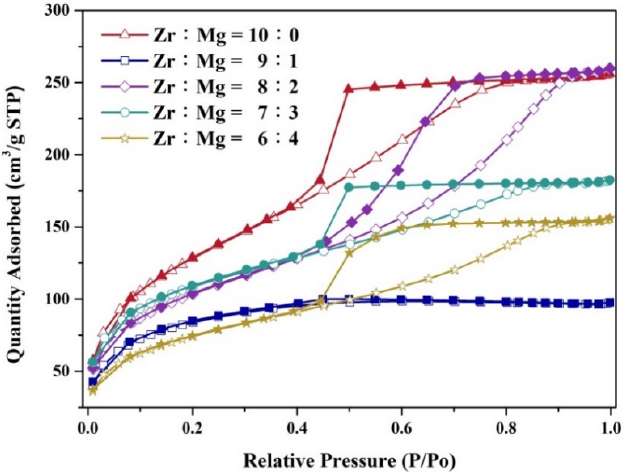
Figure 3. Nitrogen adsorption/desorption isotherms of the as-prepared Zr–Mg mixed oxide aerogels with different Zr/Mg molar ratios.